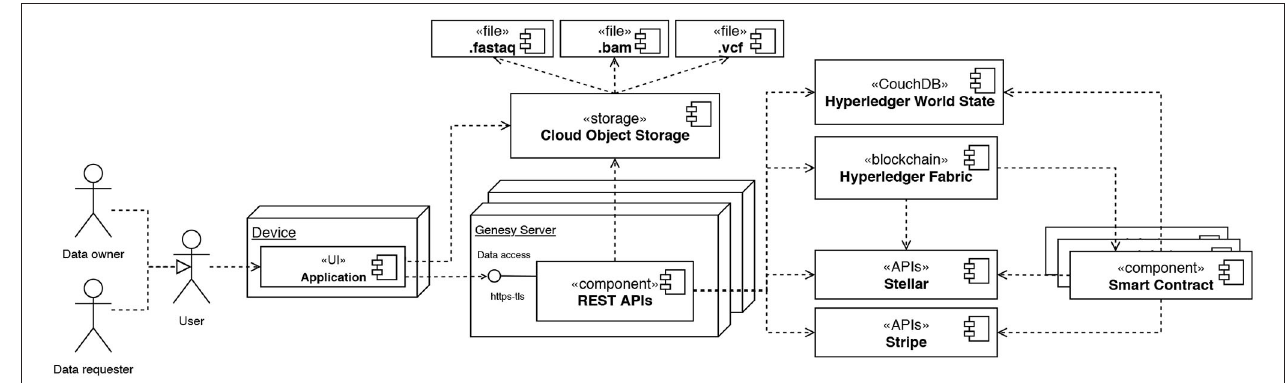
FIGURE 3 | Deployment diagram using the UML notation modeling the high-level architecture of Genesy. Data owners and data requester can access the system via a web/smartphone application through the REST APIs provided by Genesy. The APIs put users in contact with each other, and facilitate the operations for reading, writing and transferring